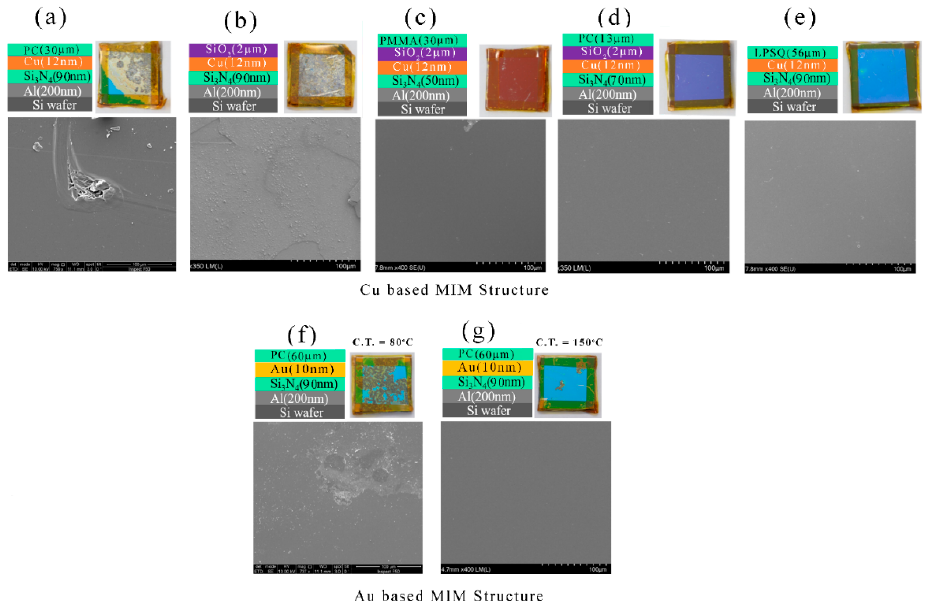
Figure 10. The scanning electron microscopy (SEM) images of the salt spray test specimens: ( a – e ) Cu-based MIM structures; ( f – g ) Au-based MIM structures. The scale bar in all images is 100 μ m.